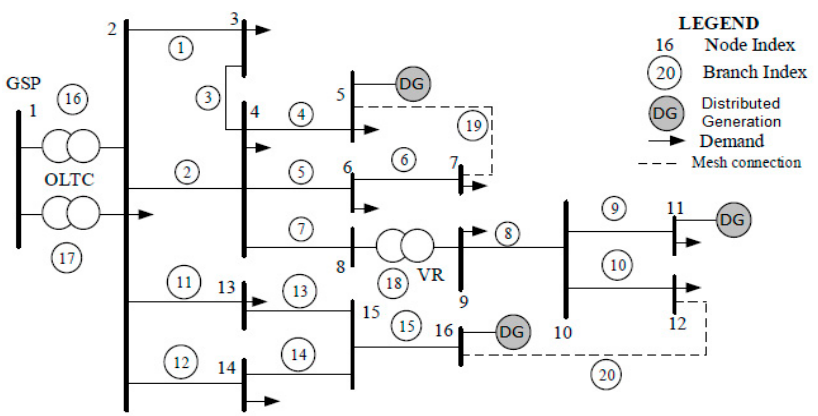
Figure 2. Weakly meshed 16-bus UKGDS with the allocation of DGs.